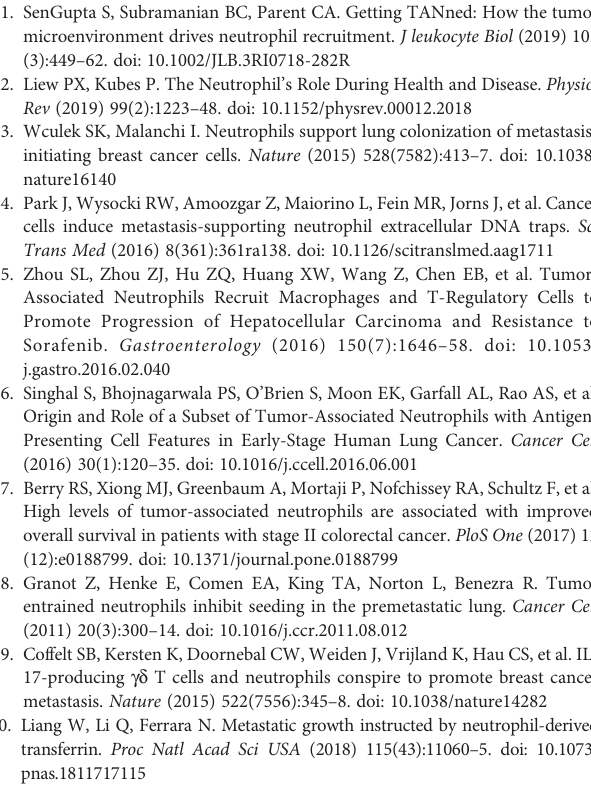
N=3 independent donors and acquired using an Axiovert fl uorescence microscope from the side of the wells facing the chemoattractants (see Methods ). Figure S5 | M4-derived active factors are ~12 kDa. (A) Representative size exclusion chromatography elution pro fi le of TCM from M4 cells. (B) Representative bright fi eld images of neutrophils exposed to vehicle control DPBS (Bi) or TCM peak fractions (fracn) (Bii-vi) as labeled in (A) and corresponding to different molecular weights. (C) Graph depicting the circularity of neutrophils stimulated with controls (fMLF, DPBS, TCM) or TCM fractions with gradually decreasing molecular weight. Data showmean ± SD from N=1donor withtwo dotsrepresentingmeancircularity of all neutrophils from two randomly selected imaging fi elds. Movies S1 and S2 | Videos showing time-lapse imaging of labeled neutrophils migrating in 3D collagen matrices in response to M4 TCM (S1) or media (S2) placed ontheright.Imagesweretakenevery25secover40min.Individualcelltracksinthe immediate vicinity of TCM-collagen boundary are shown. Movies S3 and S4 | Videos showing time-lapse imaging of labeled neutrophils migrating in 3D collagen matrices in response to 500 nM CXCL8 (S3) or buffer (S4) placed on the right. Images were taken every 25 sec over 50 min. Individual cell tracks in the vicinity of TCM-collagen boundary are shown. Movies S5 – S8 | Videos showing z-stacks of 2-photon images of M4 (Total slice no. 38; S5), MDA-MB-231 (Total slice no. 23; S6), BT549 (Total slice no. 31; S7), and BT474 (Total slice no. 147; S8) spheroids stained with a nuclear dye DRAQ5. Movies S9 and S10 | Videos showing time-lapse imaging of the neutrophil-M4 (S9) and -BT474 (S10) spheroid co-culture system. Live-imaging was initiated one hour after the addition of neutrophils to the spheroids. Images were taken every 3 min for 20 hrs. Individual neutrophil tracks are